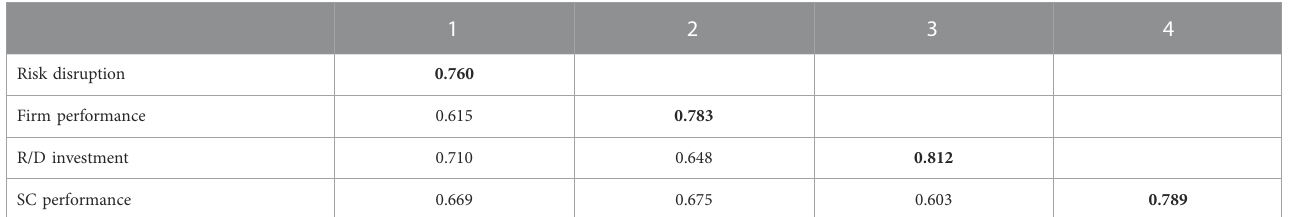
TABLE 3 Discriminant